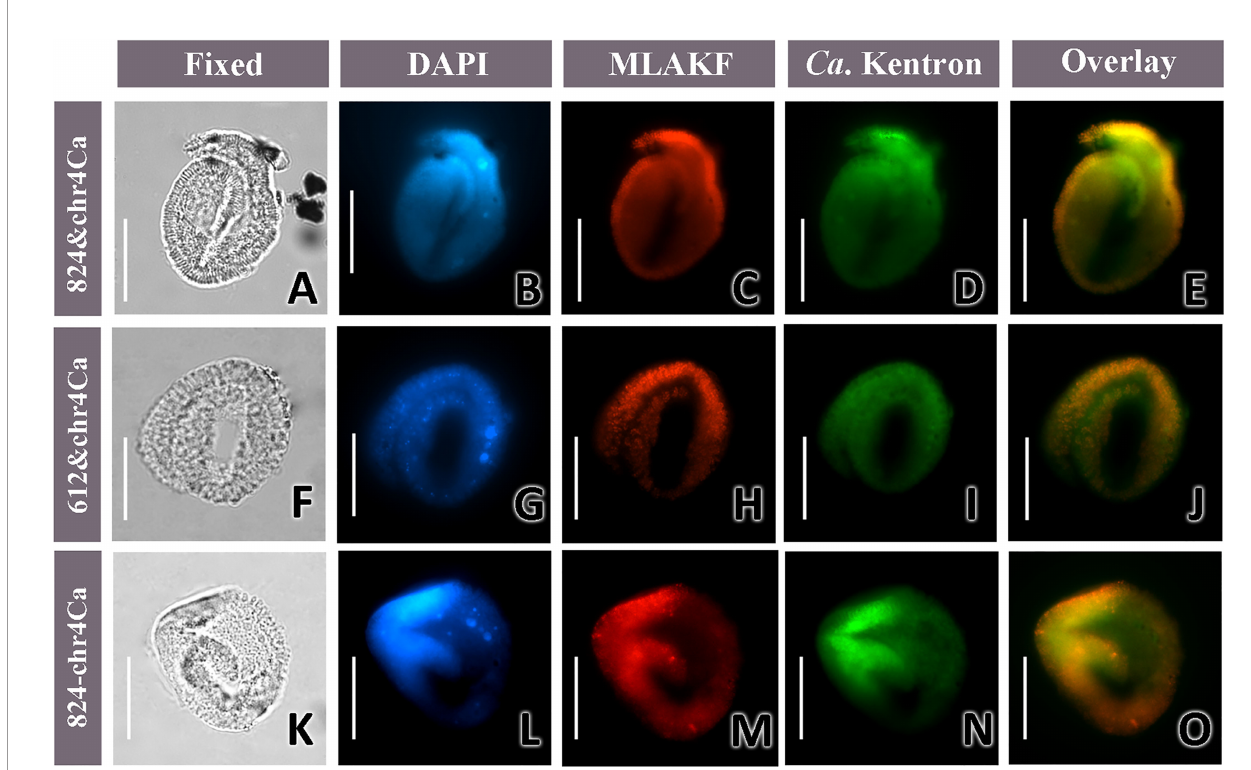
FIGURE 8 | Double-label experiments on the same cell with both the Cy3-C01-612/824 and AF488-chr4Ca probes; (A, F, K) microphotographs of the fi xed cells in the bright fi eld; (B, G, L) DAPI staining; (C, H, M) species-speci fi c probes Cy3-C01-824 (C, M) and Cy3-C01-612 (H) ; (D, I, N) species-speci fi c probe AF488- chr4Ca; and (E, J, O) overlays of Cy3 and AF488 images. Scale bars = 50 m m (A – O) . For the cells in images A and F , the probe solutions of 3.5 m l of Cy3-C01-824/ 612 plus 0.5 m l of AF488-chrCa were applied, while for the one in K , 2 m l of Cy3-C01-824 plus 2 m l of AF488-chrCa were